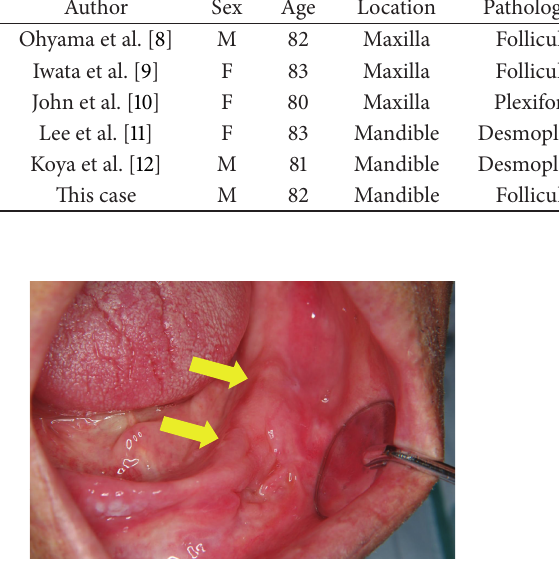
Figure 1: Intraoral findings at the first visit. The upper and lower jawswereedentulous,witharelativelyirregularborderfromthecen- tre of the mandible to the gingiva of the molar region on the left side. Diffuse swelling was observed, accompanied by surface ulceration.